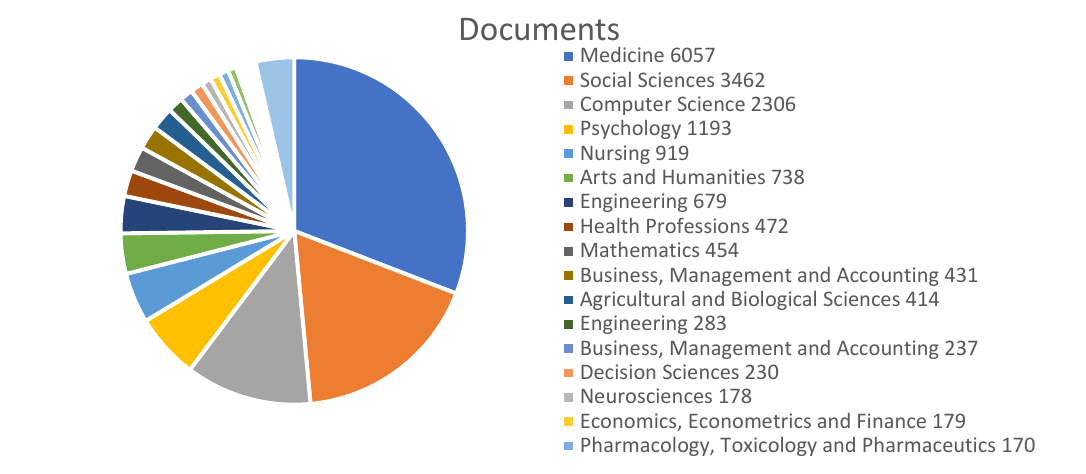
Figure 8. Distribution of scientific productions according to the main thematic areas.